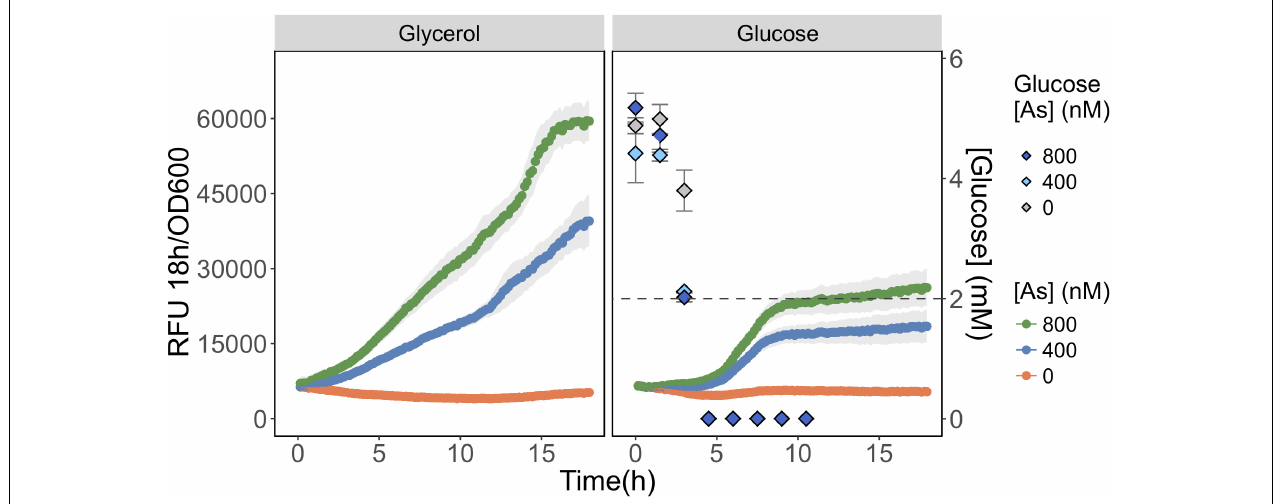
FIGURE 5 | Detection of As(III) is hampered in glucose grown biosensor cultures. As(III) was detected in biosensor cultures grown and exposed in media containing glycerol (left) or glucose (right) as primary carbon sources. The RFU per OD 600 is given for the 18 h following arsenic exposure. The concentration of glucose in culture supernatant fractions was quantified using HPLC-ELSD over time and is presented on the secondary y -axis. The mean and standard deviations of biological triplicate exposures are represented for both RFU and the glucose concentration estimates. HPLC-ELSD limit of detection is presented as the dotted